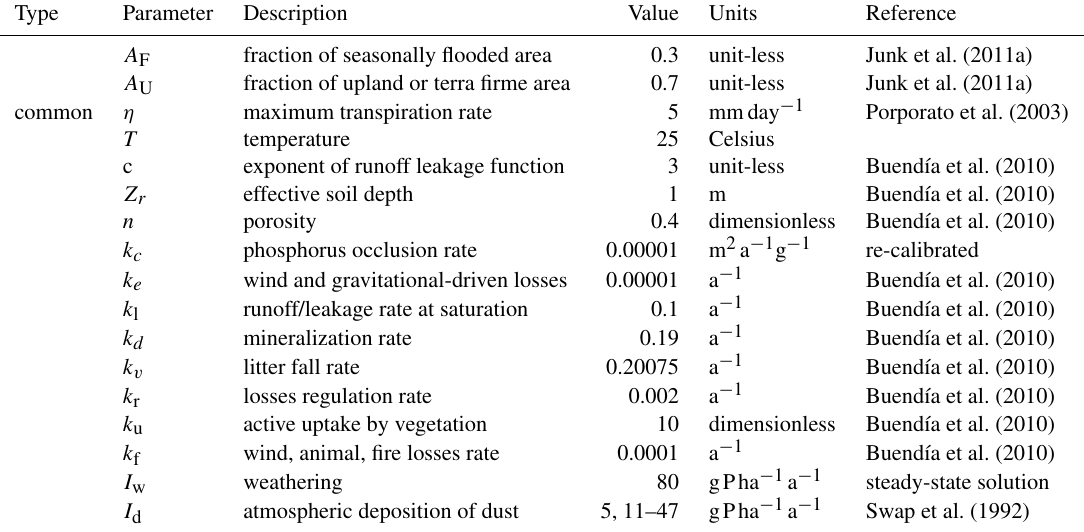
Table 2. Description of model